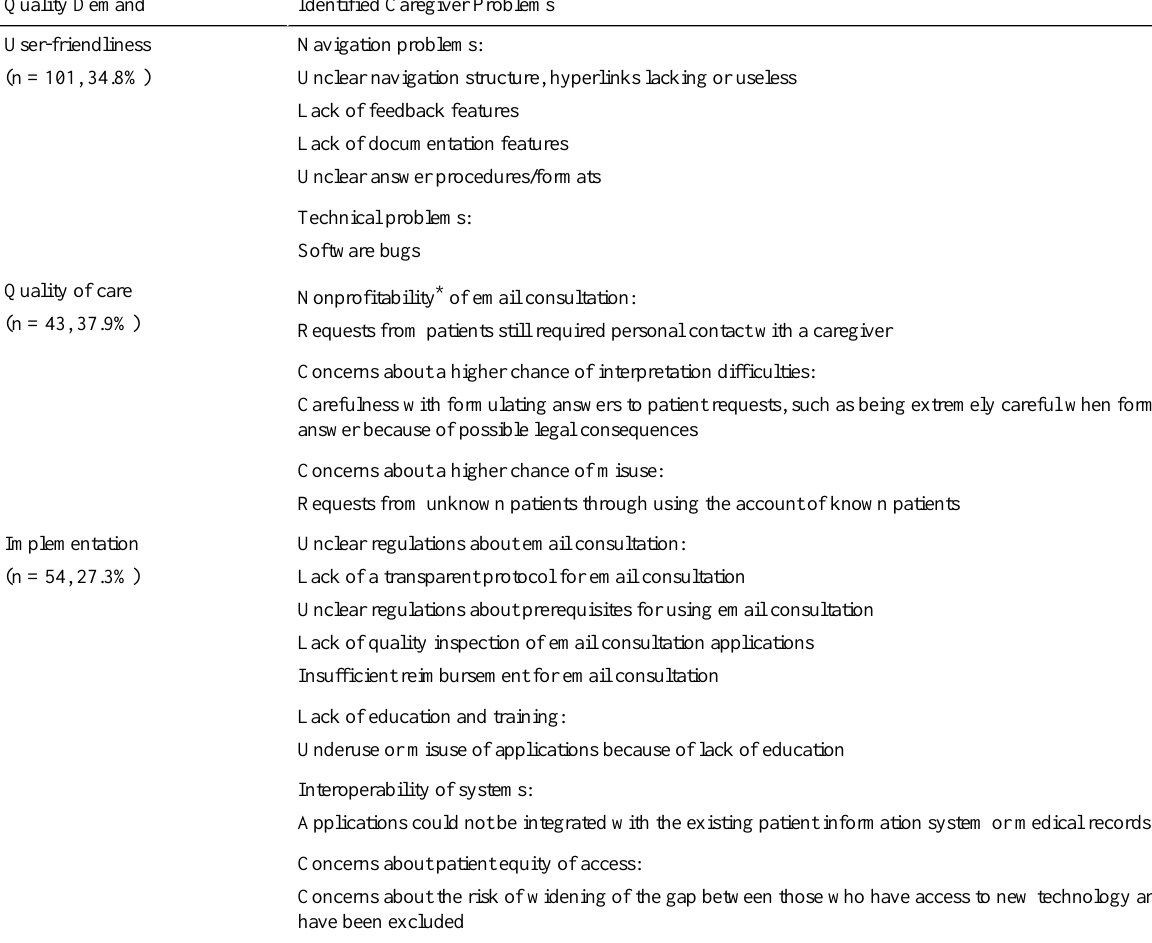
Table 2. Overview of caregiver problems (N =